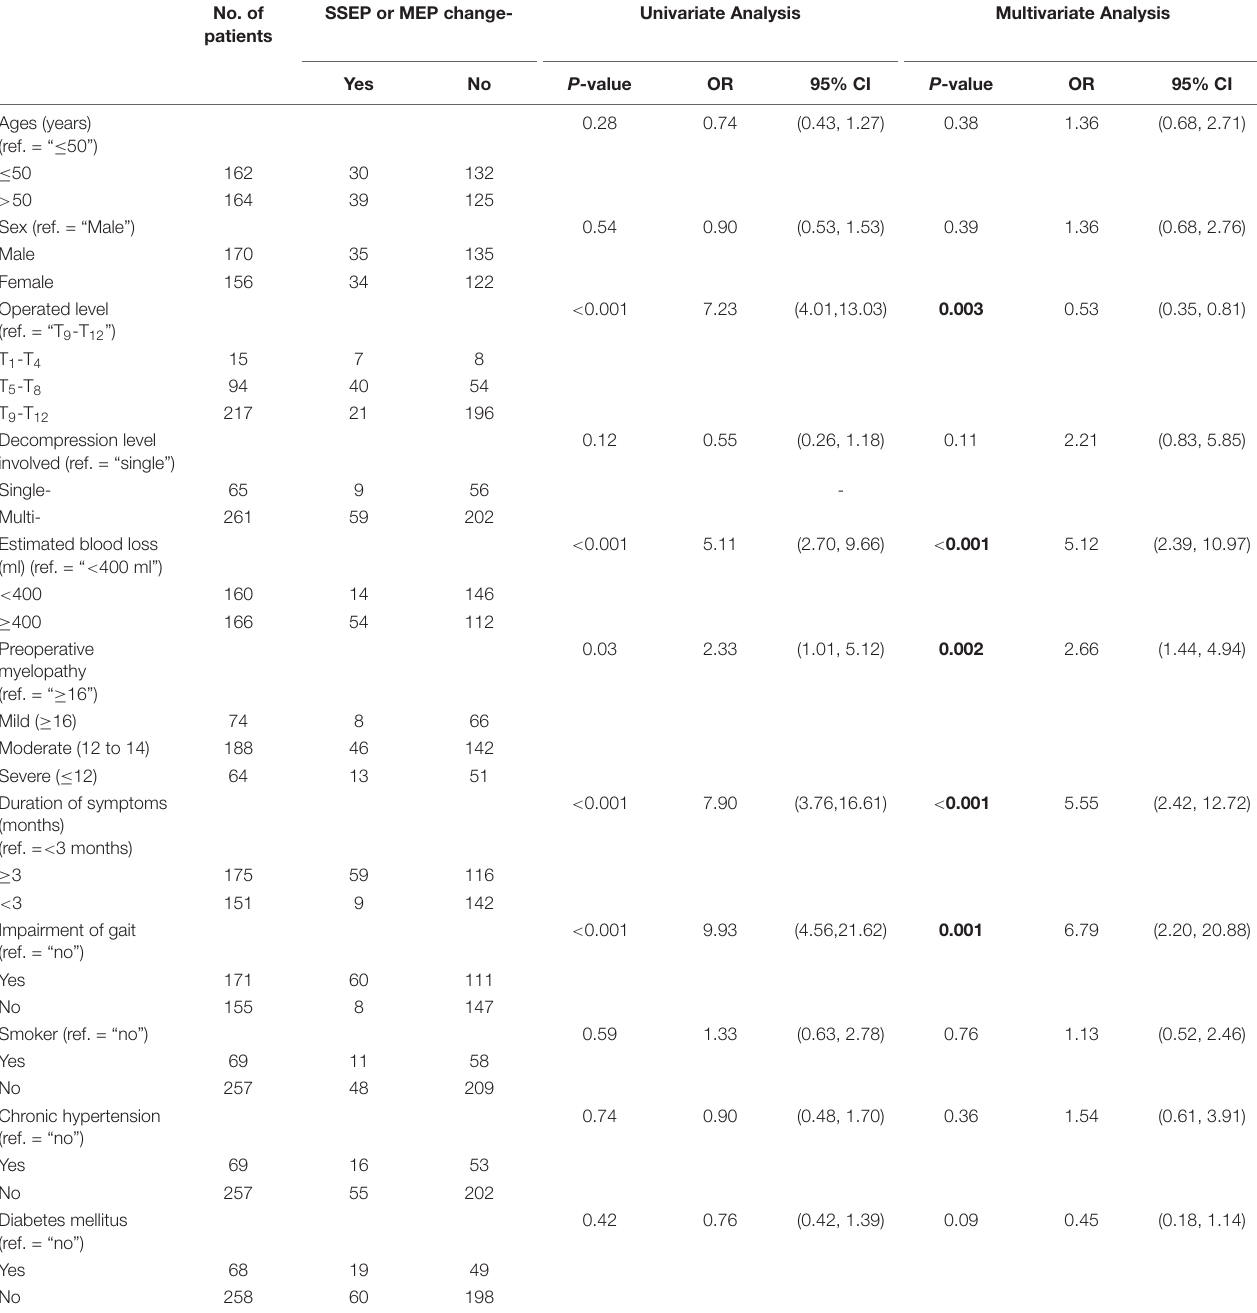
TABLE 4 | Univariate and multivariate logistic analysis of factors associated with a high probability of “SSSEP or MEP change” ( n = 68) during posterior decompression surgery for thoracic spinal stenosis (TSS). No. of SSEP or MEP change- Univariate Analysis Multivariate patients